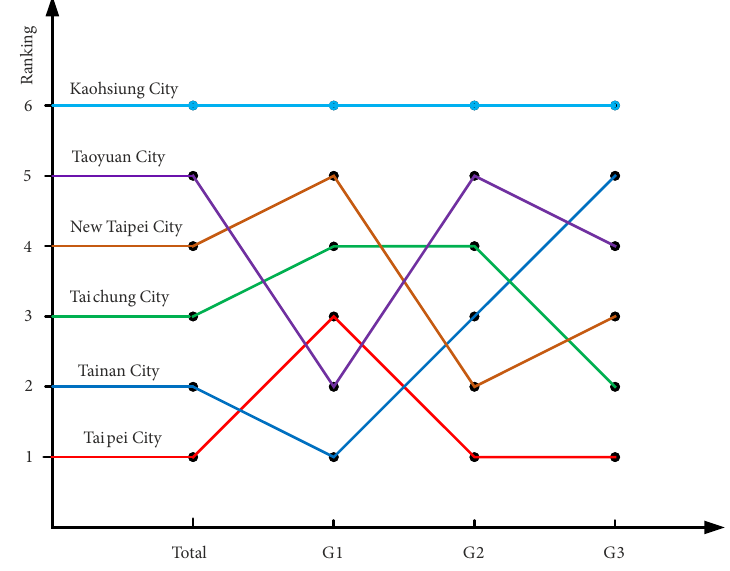
Figure 6. Ranking of the six cities for different groups in government support